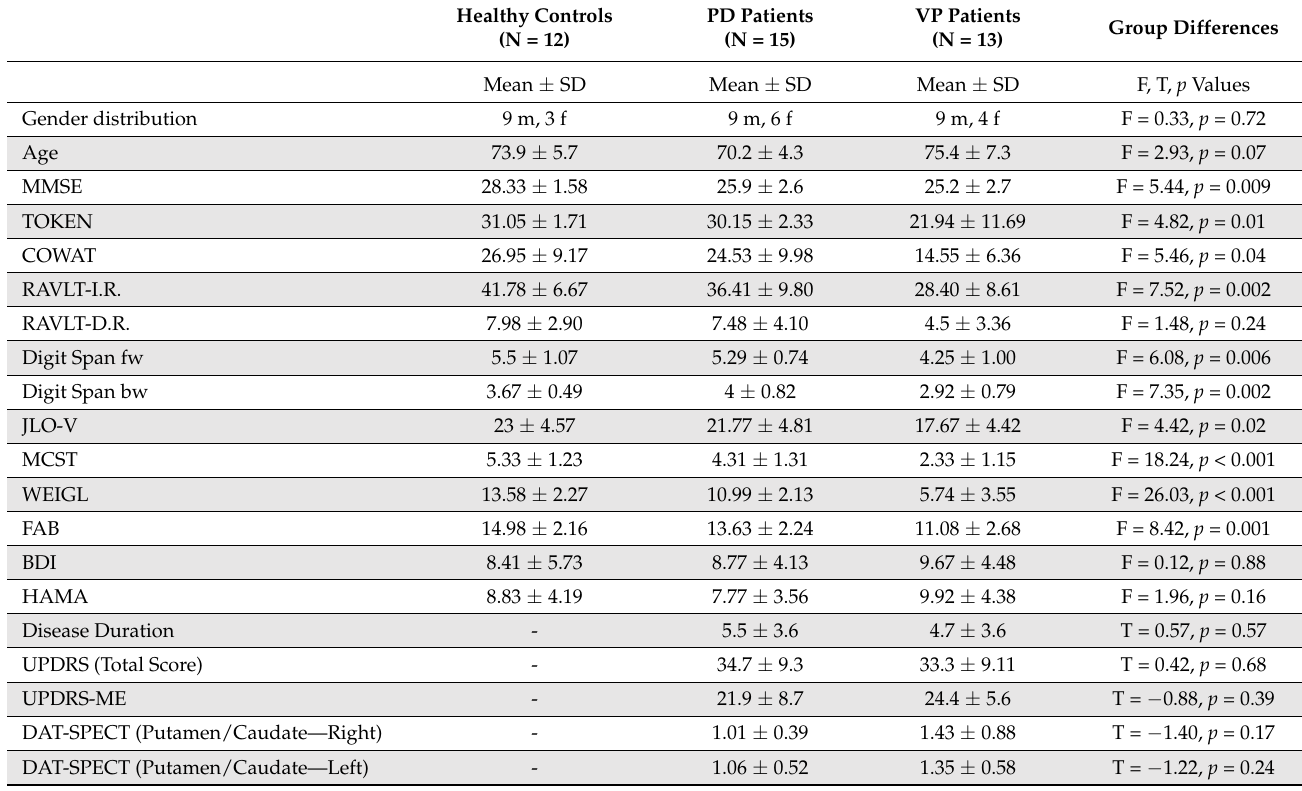
Table 1. Demographic, clinical and scintigraphic features of the